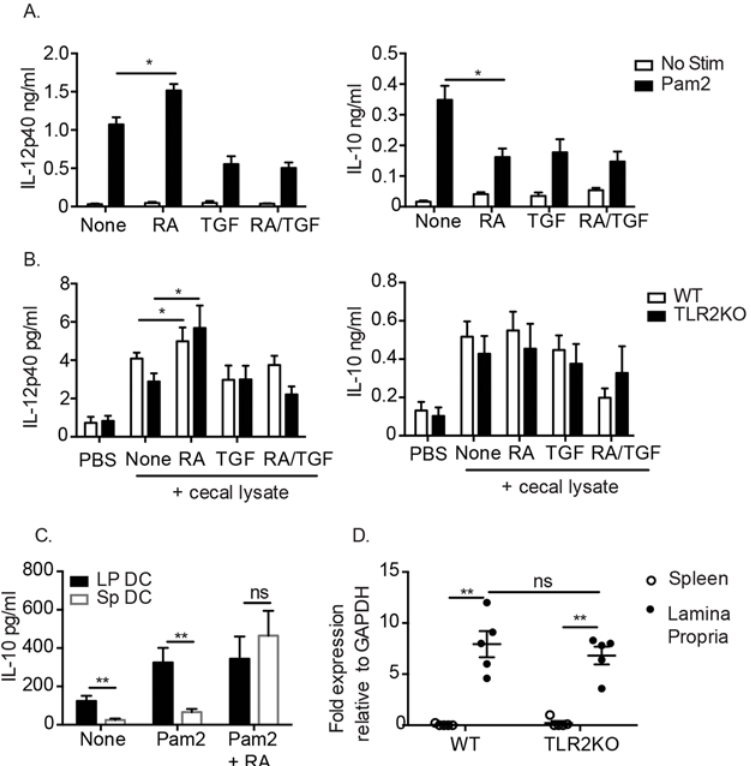
Fig 3. RA potentiates cytokine responses in both WT and TLR2KO DC. (A) WT splenic DC were cultured with 100 ng/ml of TLR2 ligand Pam2CysK4 and (B) WT and TLR2KO splenic DC were cultured with 10 μ g/ml cecal lysate in the presence or absence of RA, TGF- β or RA/TGF- β . Supernatants were analyzed after 24 hours for cytokine production by ELISA. (C) Comparison of IL-10 IL- production from CD103 + LP DC and CD103 + SP DC. (D) Transcript levels of aldh1a2 in spleen and LP of na ï ve WT and TLR2KO mice determined by quantitative PCR. For (A-C), data are the mean ± SEM of three independent experiments, for (D) 5 individual mice were analyzed. * , p < 0.05, ** , p < 0.01 using Student ’ s